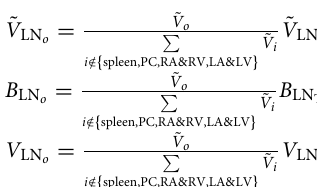
nodes is modified accordingly (see Supplementary Material for explicit forms of the equations). Finally, T cells that have not extravasated from the organ’s vasculature, combined with the lymph node outflow, return to the heart (right atrium and right ventricle), the pulmonary circuit, and then back to the heart chambers (left atrium and left ventricle). While T cells undergo the processes of proliferation in the bone marrow and depletion in